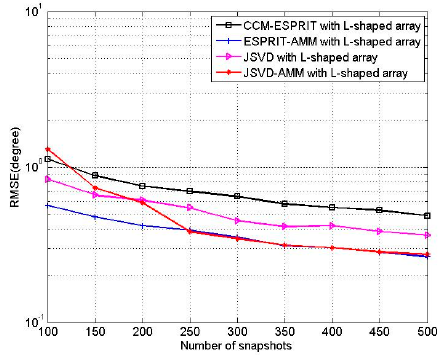
Figure 12. RMSE of four algorithms versus SNR. Figure 13. RMSE of four algorithms versus snapshots. Figure 13. RMSE of four algorithms versus snapshots. Figure 13. RMSE of four algorithms versus